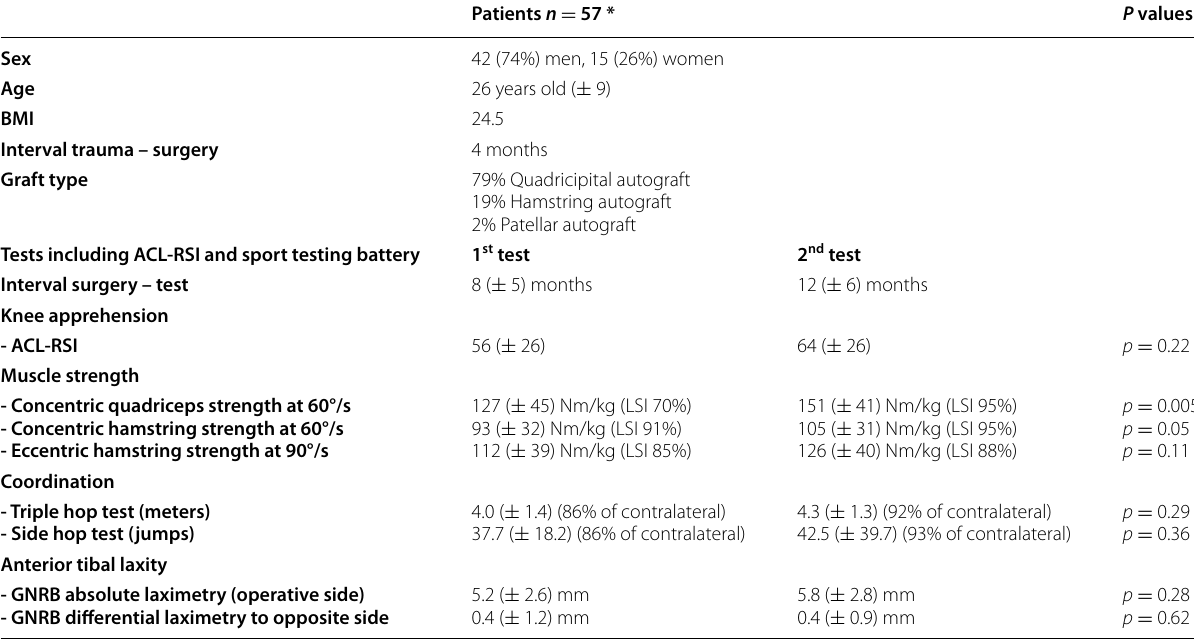
* Exclusion of 246 patients who only had one ACL-RSI assessment with one sport testing battery BMI Body mass index , ACL-RSI Anterior cruciate ligament return to sport after injury, LSI Limb symetry